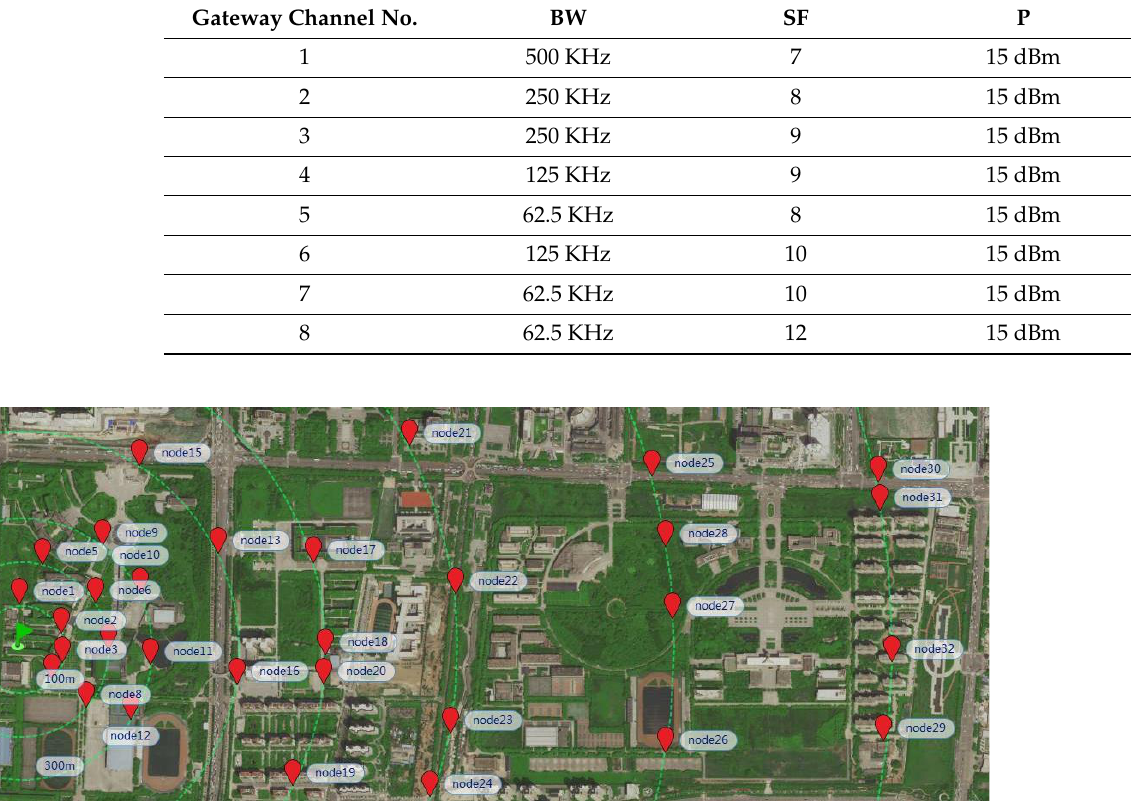
Table 8. Gateway channel parameter configuration.